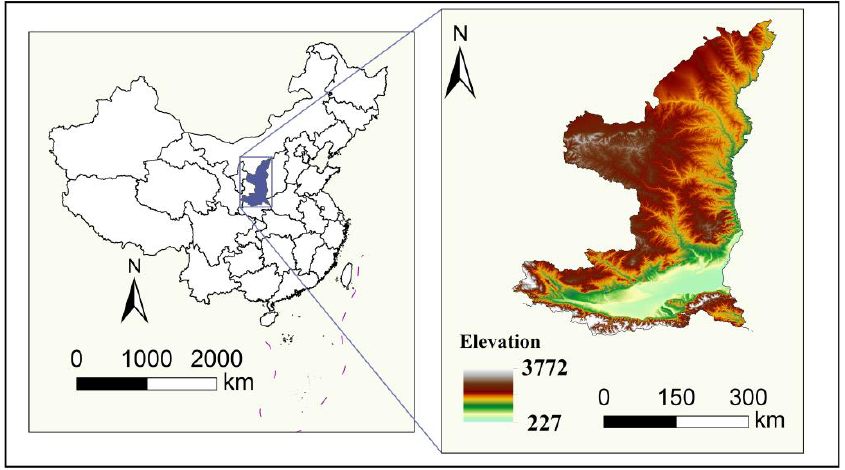
Figure 1. The location of the Yellow River Basin in Shaanxi Province, China.